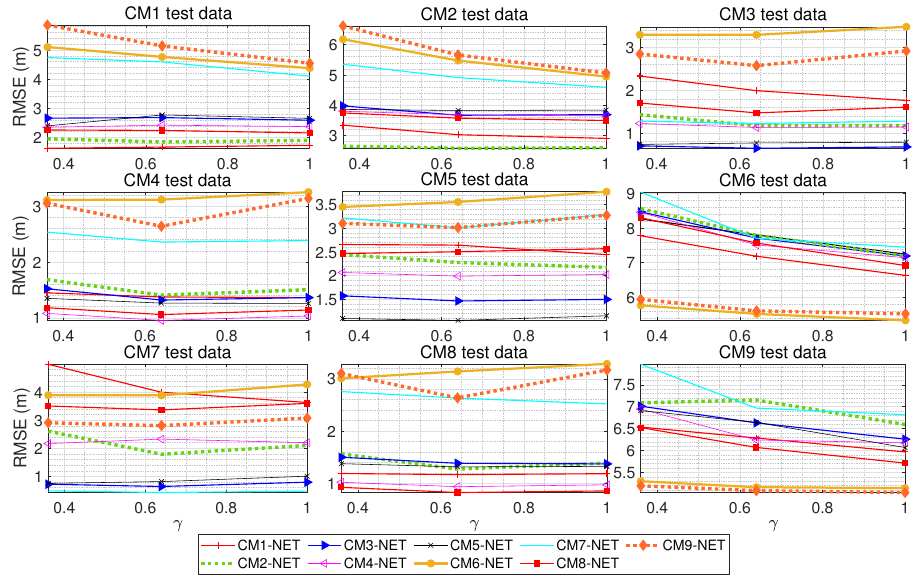
Figure 12. RMSE ( y -axis) across γ ( x -axis) on an area of 225 m 2 . CM#-NET is a CNN that is trained by using data generated under CM#. The CM#-NET is tested with various